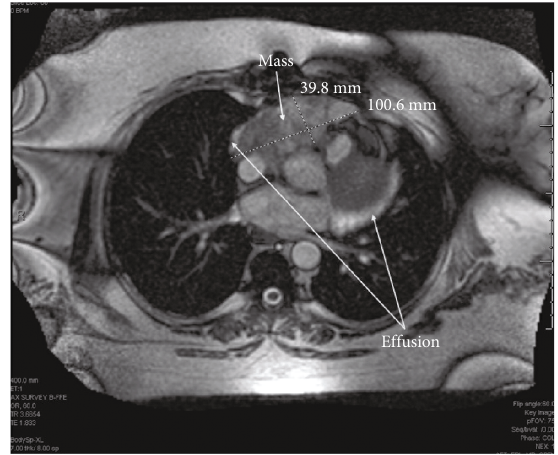
Figure 3: Follow-up magnetic resonance imaging demonstrated decreased size of the lesion posttreatment measuring 3 : 98 × 10 : 1